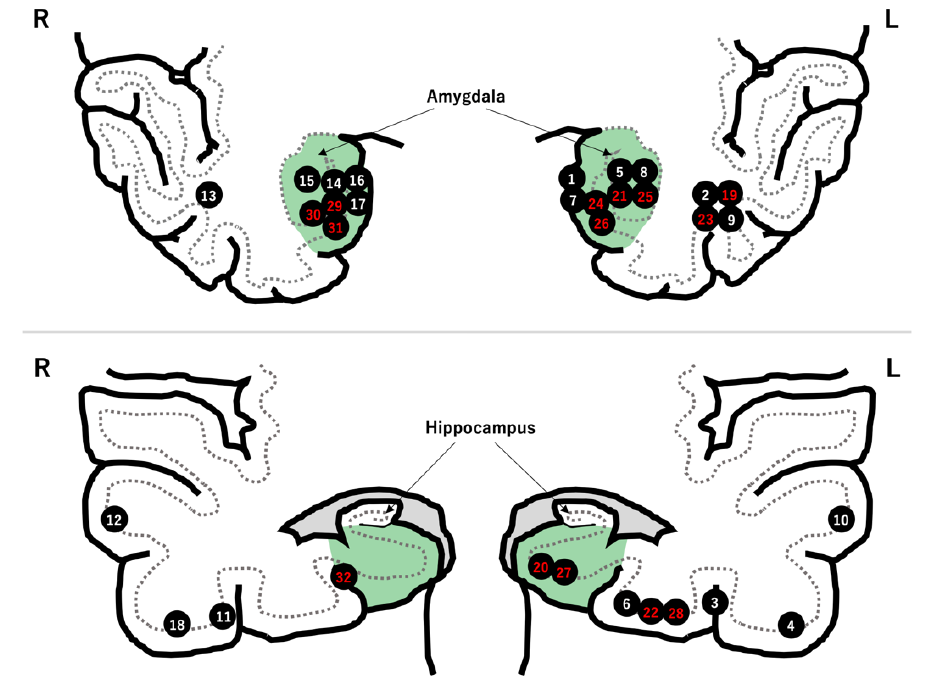
Figure 1. Locations of the 32 LEATs. There were 18 tumors in the mesial temporal region (green zone). The patient number is highlighted in red after hippocampal resection. Table 2. Surgery and surgical